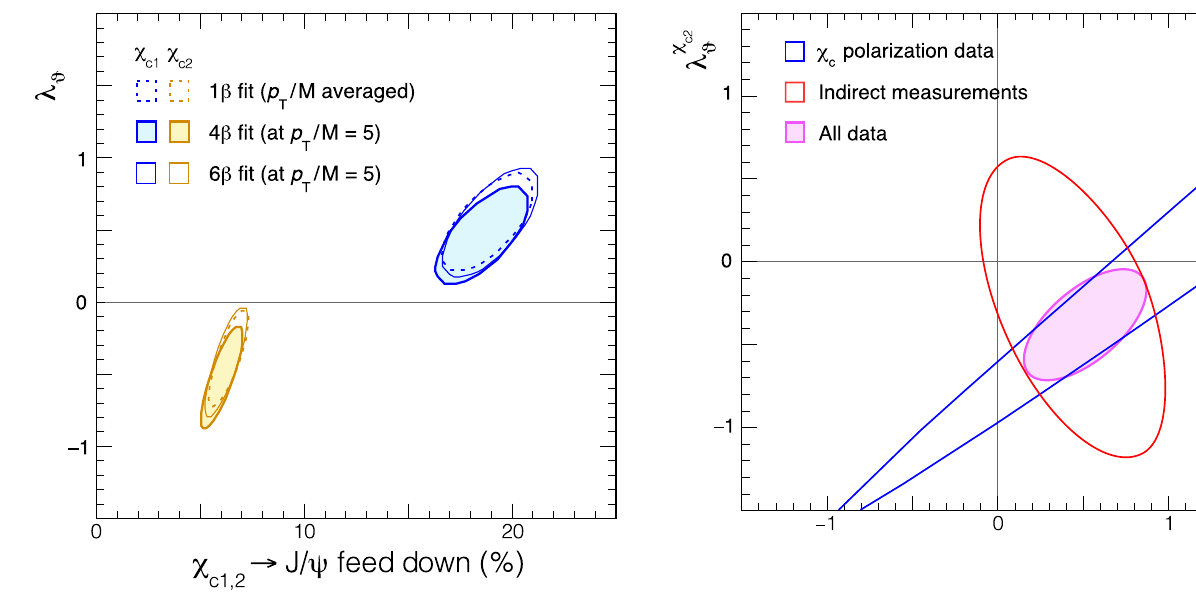
χ χ c 1 ( c 2 ) feed-down contribution to